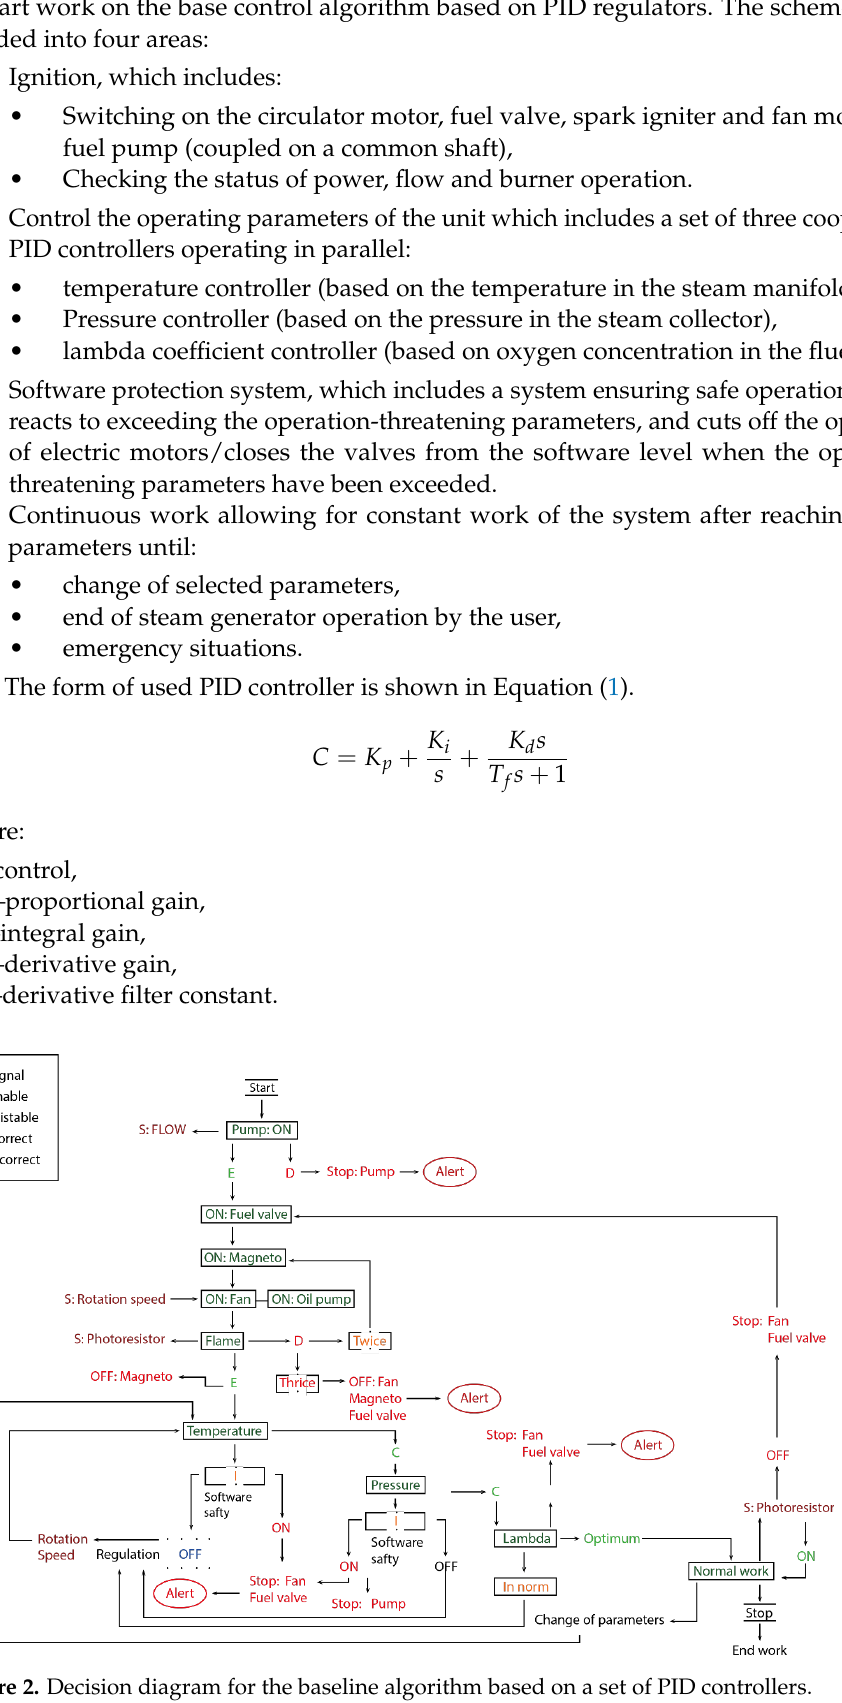
Figure 2. Decision diagram for the baseline algorithm based on a set of PID